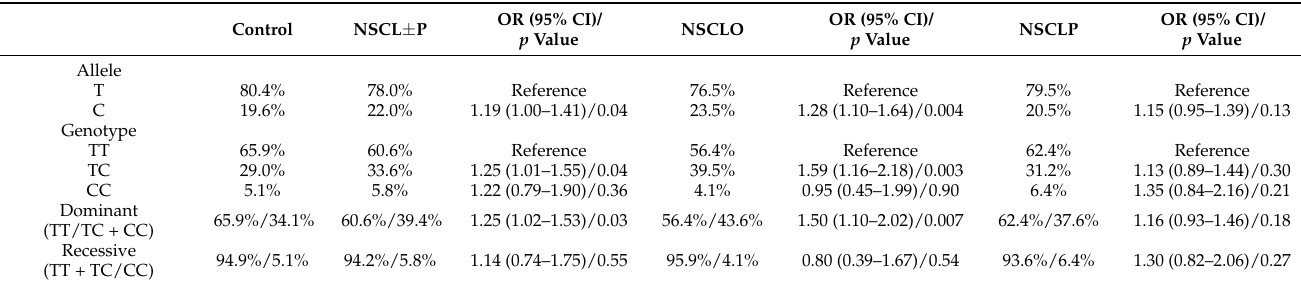
Table 2. Association between FOS rs1046117 and the risk of nonsyndromic cleft lip with or without cleft palate (NSCL ± P), nonsyndromic cleft lip only (NSCLO) and nonsyndromic cleft lip and palate (NSCLP). p values were adjusted for covariates by logistic regression analysis.